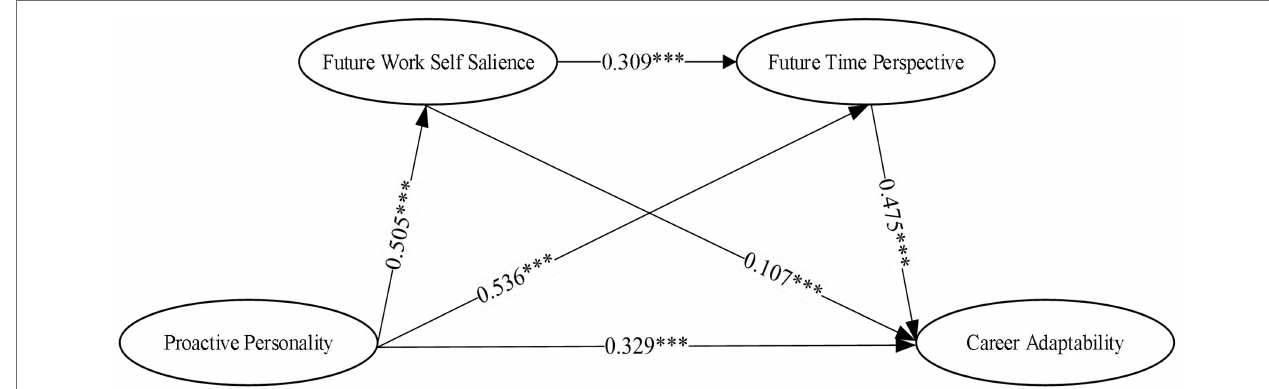
FIGURE 2 | Path of the influence of proactive personality on career adaptability. *** p < 0.001.